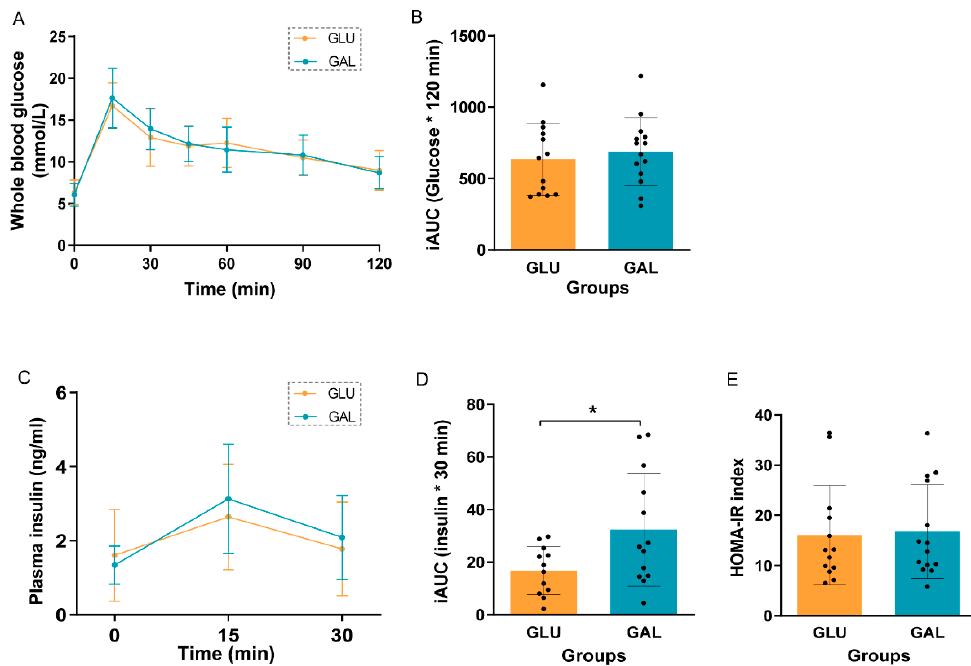
Figure 2. Oral glucose tolerance test (OGTT) in GLU and GAL mice after five weeks on a HFD. ( A ) Blood glucose curves over time after a 2.0 g/kg body weight gavage, ( B ) incremental area under the curve (iAUC) of the glucose curve, ( C ) plasma insulin concentrations in the first 30 min of OGTT, ( D ) iAUC of the insulin curve, and ( E ) homeostatic model assessment for the insulin resistance (HOMA-IR) index. Values are given as mean ± SD, n = 12–14. * p < 0.05.